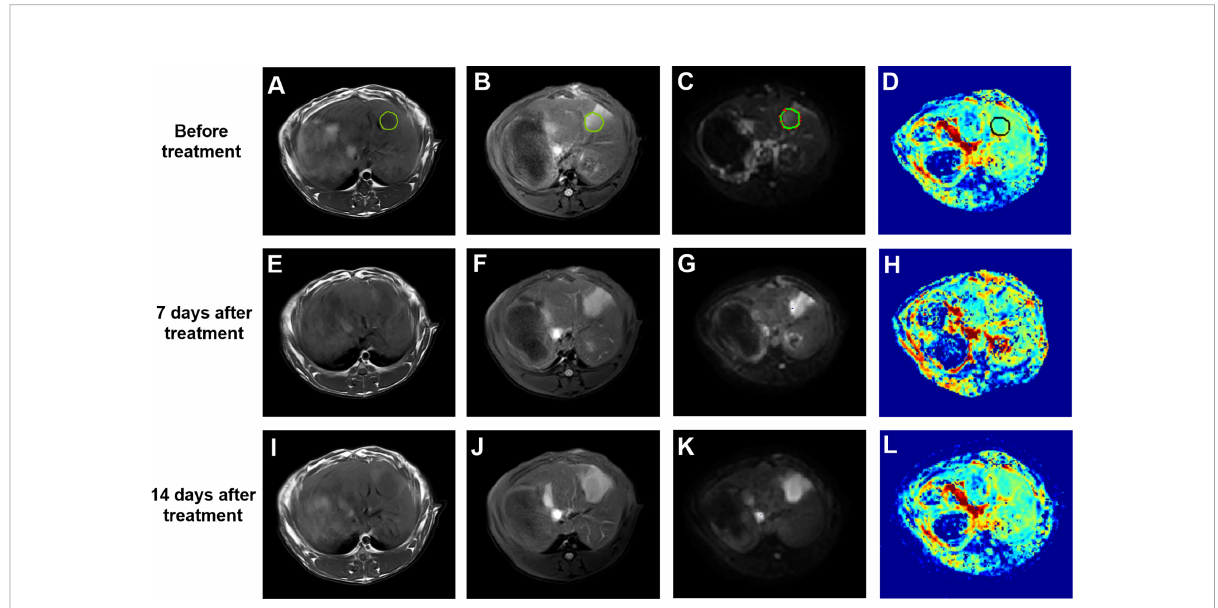
FIGURE 3 (A – D) T1WI, T2WI, DWI (b=500 s/mm 2 ) and pseudo-color image of D before treatment, the green or black circle is the area where the tumor was planted. (E – H) T1WI, T2WI, DWI (b=500 s/mm 2 ) and pseudo-color image of D 7 days after treatment. (I – L) T1WI, T2WI, DWI (b=500 s/ mm 2 ) and pseudo-color image of D 14 days after treatment. DWI, diffusion-weighted imaging; D, true diffusion coef fi